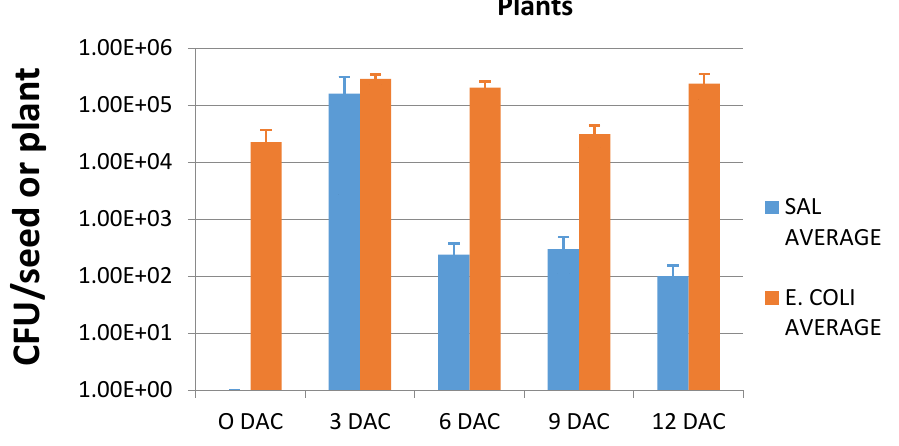
Figure 7. Change in microbial population (average CFU/plant) for Micro-Tom seeds that were contaminated with Salmonella Typhimurium-GFP (SAL Average) and E. coli O157:H7-GFP (E. COLI Average) and sampled 0, 3, 6, 9, and 12 days after contamination (DAC). Only colonies actively expressing GFP were included in the